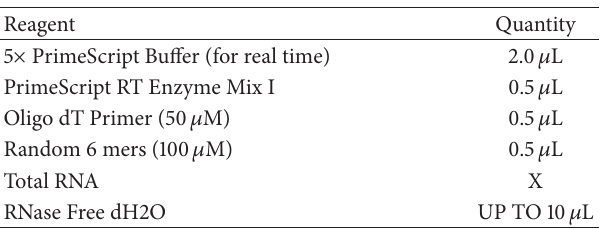
Table 1: Reverse transcription reaction system.